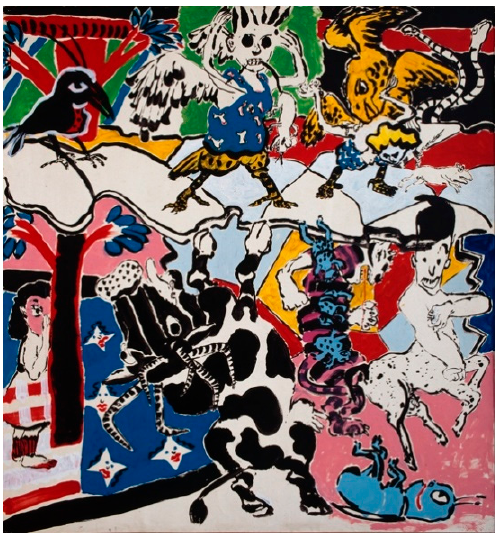
Figure 8. Paula Rego, A Árvore de Dubuffet (da série Homenagem a Dubuffet) (1985). © Aníbal Lemos/Coleção Norlinda e José Lima/Centro de Arte Oliva.